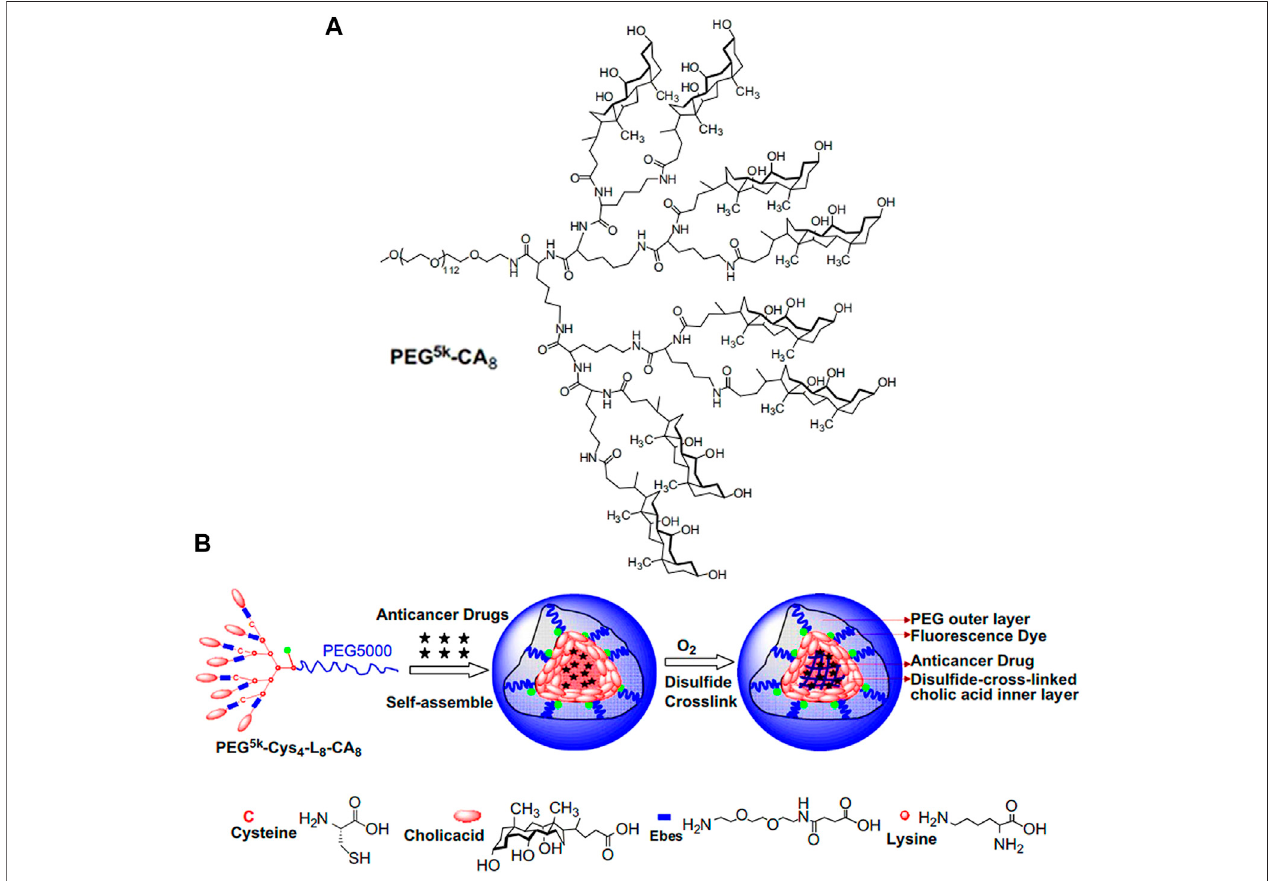
FIGURE 1 | (A) The chemical structure of PEG 5k -CA 8 G3 lysine dendrimer (Xiao et al., 2009). (B) Schematic representation of the disul fi de cross-linked micelles formed by the oxidization of thiolated PEG 5k -Cys 4 -L 8 -CA 8 after self-assemble (Li et al., 2011). Abbreviation: PEG, polyethylene glycol; CA, cholic acid; Cys, cysteine; L, lysine.